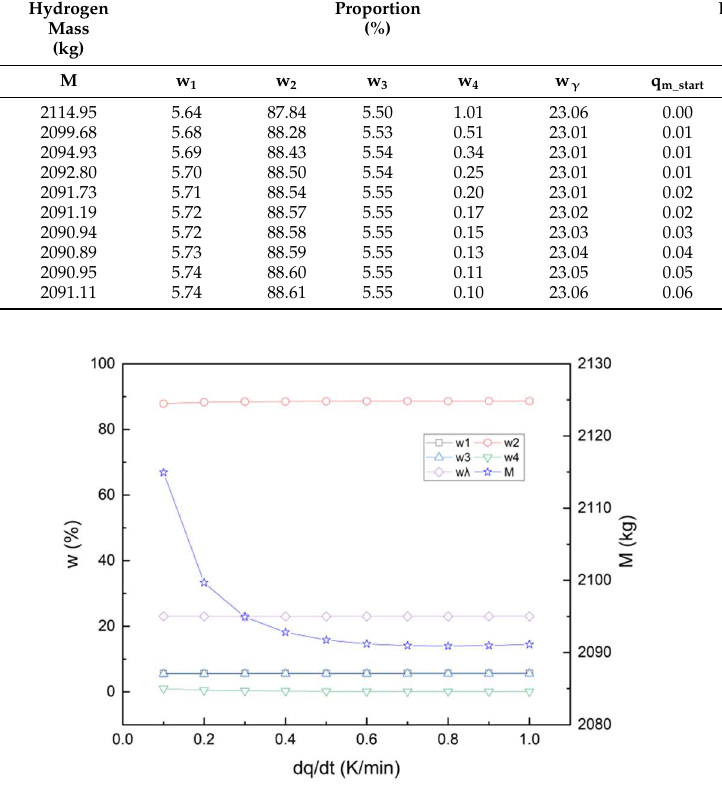
Figure 8. Percentages of liquid hydrogen consumed by various heat loads at different cooling rates and total liquid hydrogen mass.